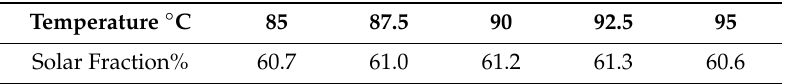
Table 8. Variation of solar coverage with an upper temperature of the solar